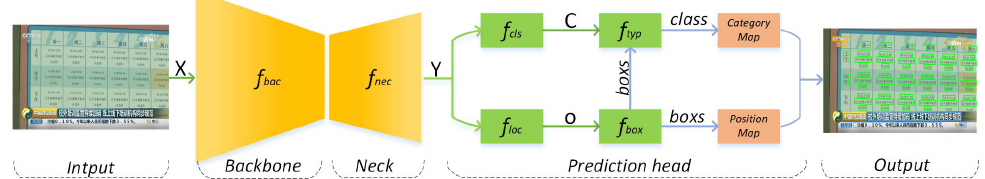
Figure 4. The generalized framework of the detection and classification network. It consists of three components, i.e., backbone, neck, and head. The backbone network ( f bac ) is used to receive the input image ( X ) and extract the image features from different scales. The neck stack ( f nec ) focuses on the fusing and re-treatment of the multiple-scale features and provides the combination features to the prediction head. The prediction head contains two branches. The upper branch predicts the category of text via f cls and f typ and the lower branch predicts the position of text via f loc and f box (the same as the prediction head of the original detection algorithm). The final results comprise the position map and corresponding category map.